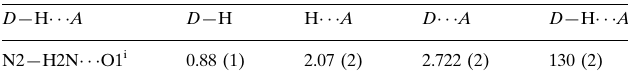
Hydrogen-bond geometry (A˚ , (cid:1)